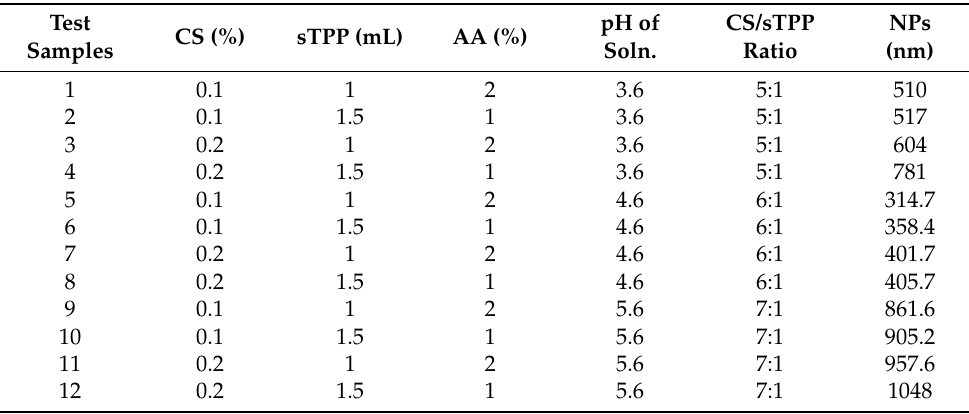
Table 3. Optimization of formulation based on particle